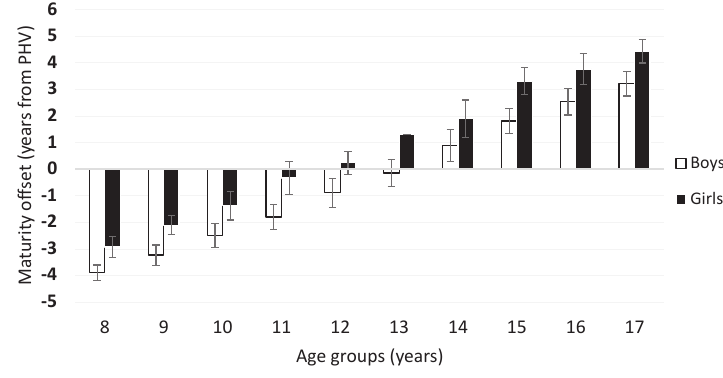
Figure 1. Age groups and maturity